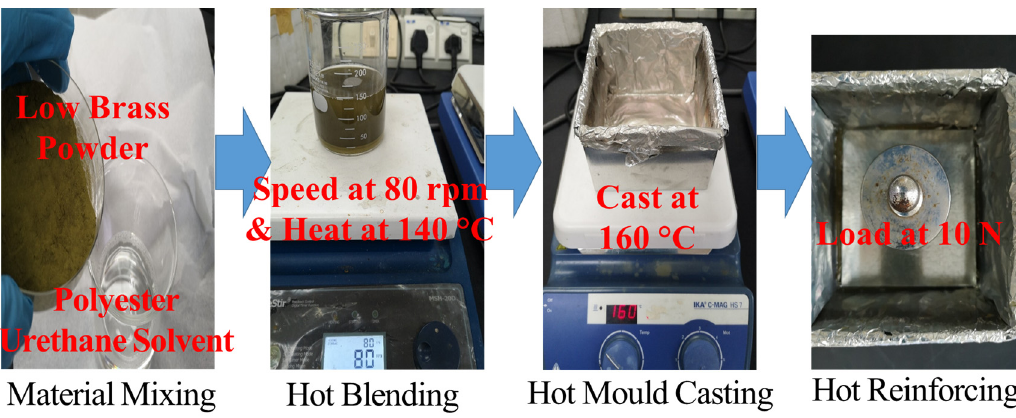
Figure 1. Metallic filler polymer reinforced process of biomaterial.